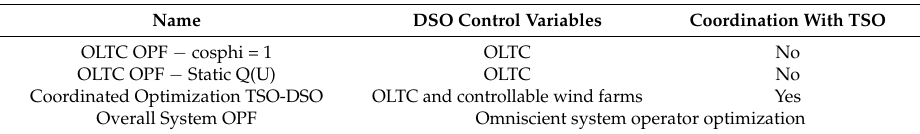
Table 1. Summary of selected scenarios.